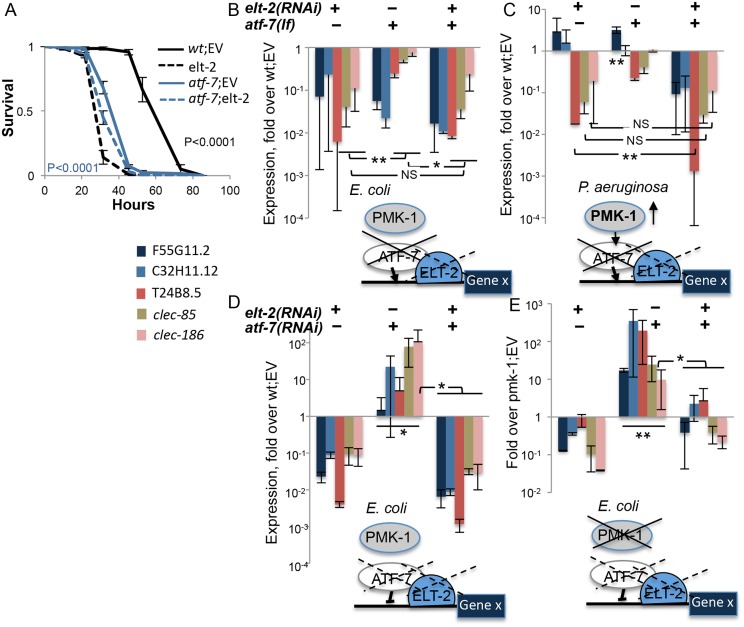

elt-2 is essential for atf-7-dependent immune gene regulation.
A. Survival curves for wildtype and atf-7(qd22qd130) animals fed with designated RNAi’s during development followed by infection. Averages ± SDs for three plates (N = 129–140 per group) in a representative experiment of several others with similar results. B-E, Gene expression (log scale) in wildtype, pmk-1(km25), and atf-7(qd22qd130) animals, fed with designated RNAi’s during development. Models depict for each panel the mode of disruption, or status, of examined factors (solid-line crosses, loss-of-function mutants; dashed-line crosses, knock-down), placing ELT-2 tentatively at the proximal promoter of immune genes (Gene X) putatively regulated by PMK-1 and ATF-7; atf-7 is depicted as an activator (arrow) or repressor (blunt-ended arrow), based on disruption effects on gene expression. RNA levels were measured in L4/YA worms. Each panel presents averages and SDs for two independent experiments. Asterisks mark inter-group significance with *p<0.05, **p<0.01, and NS, non-significant (paired t-test) for all genes in the group or in underlined subset.